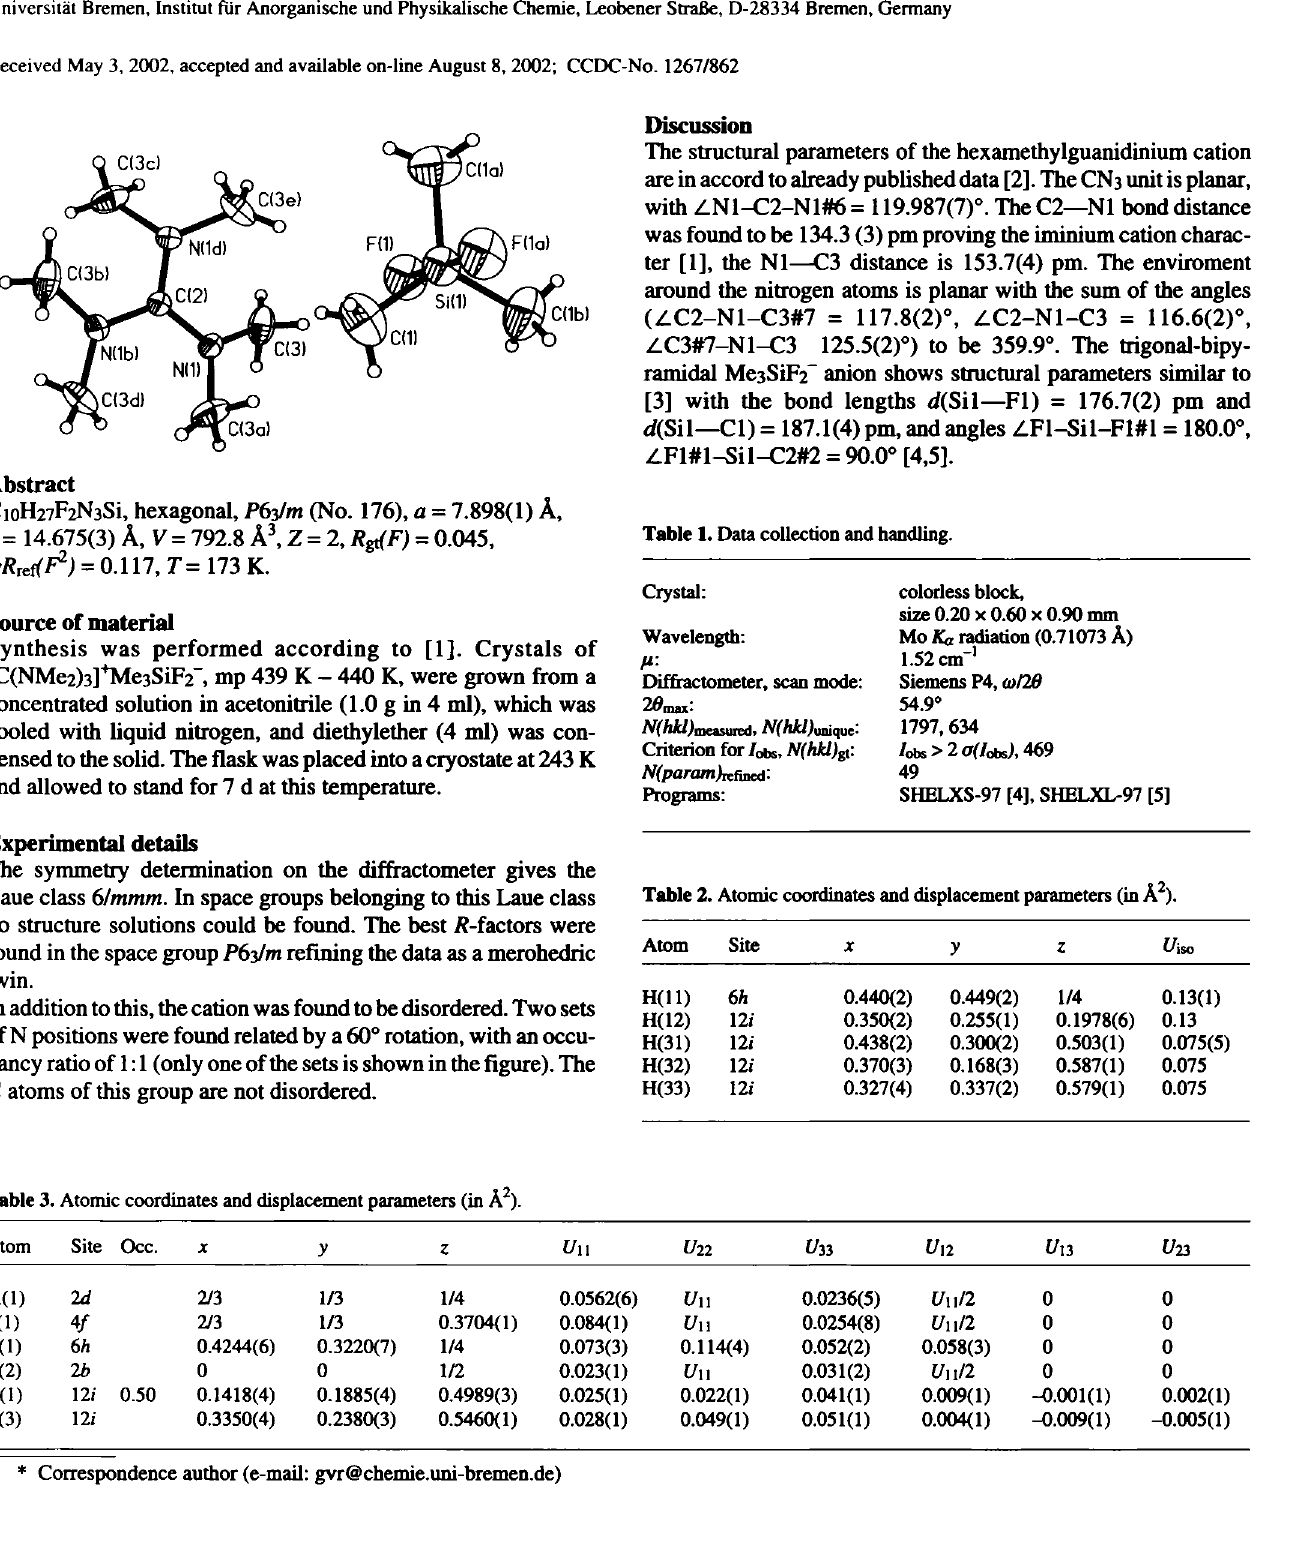
Table 3. Atomic coordinates and displacement parameters (in Â 2